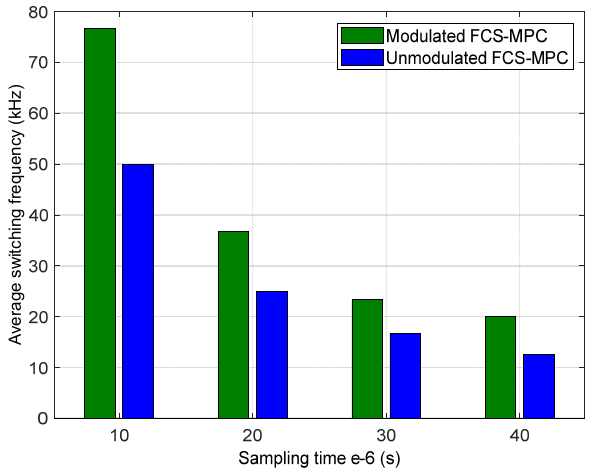
Figure 17. Comparison between the average switching frequency (in kHz) with modulated and